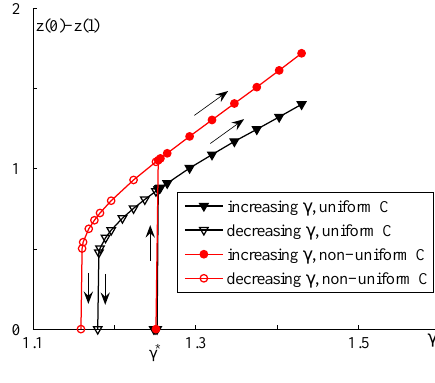
Figure 5. Dimensionless peak amplitude vs. the applied field